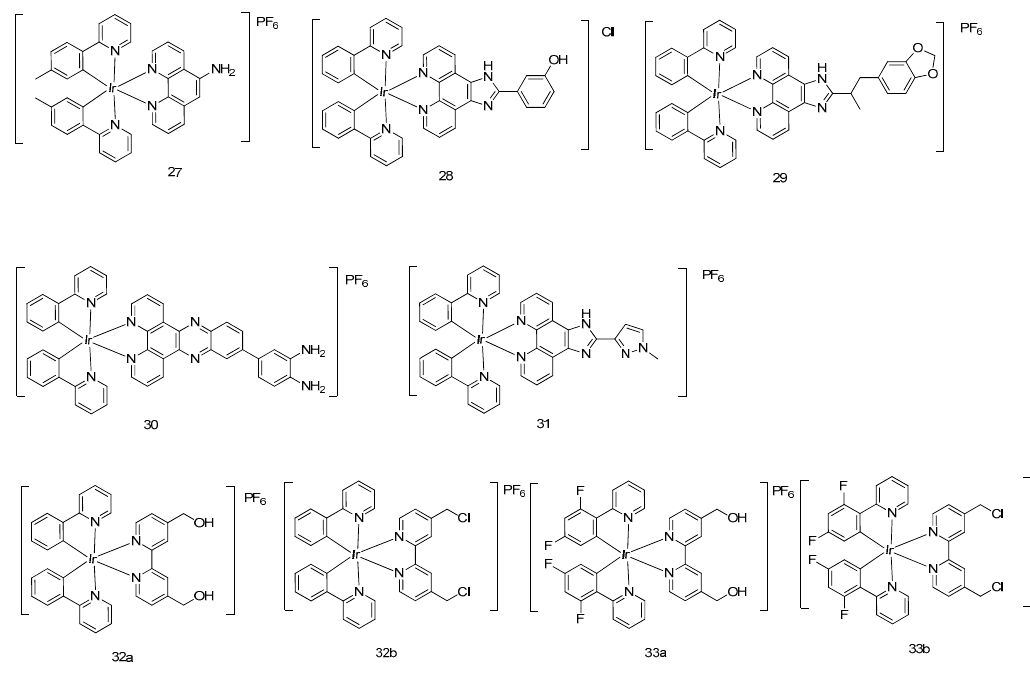
Figure 9. Various cyclometalated octahedral iridium(III) compounds.